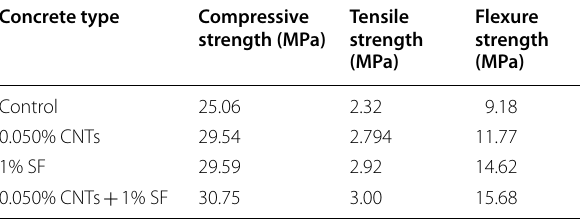
Table 5 Strengths of the control samples and the samples containing CNTs and/or